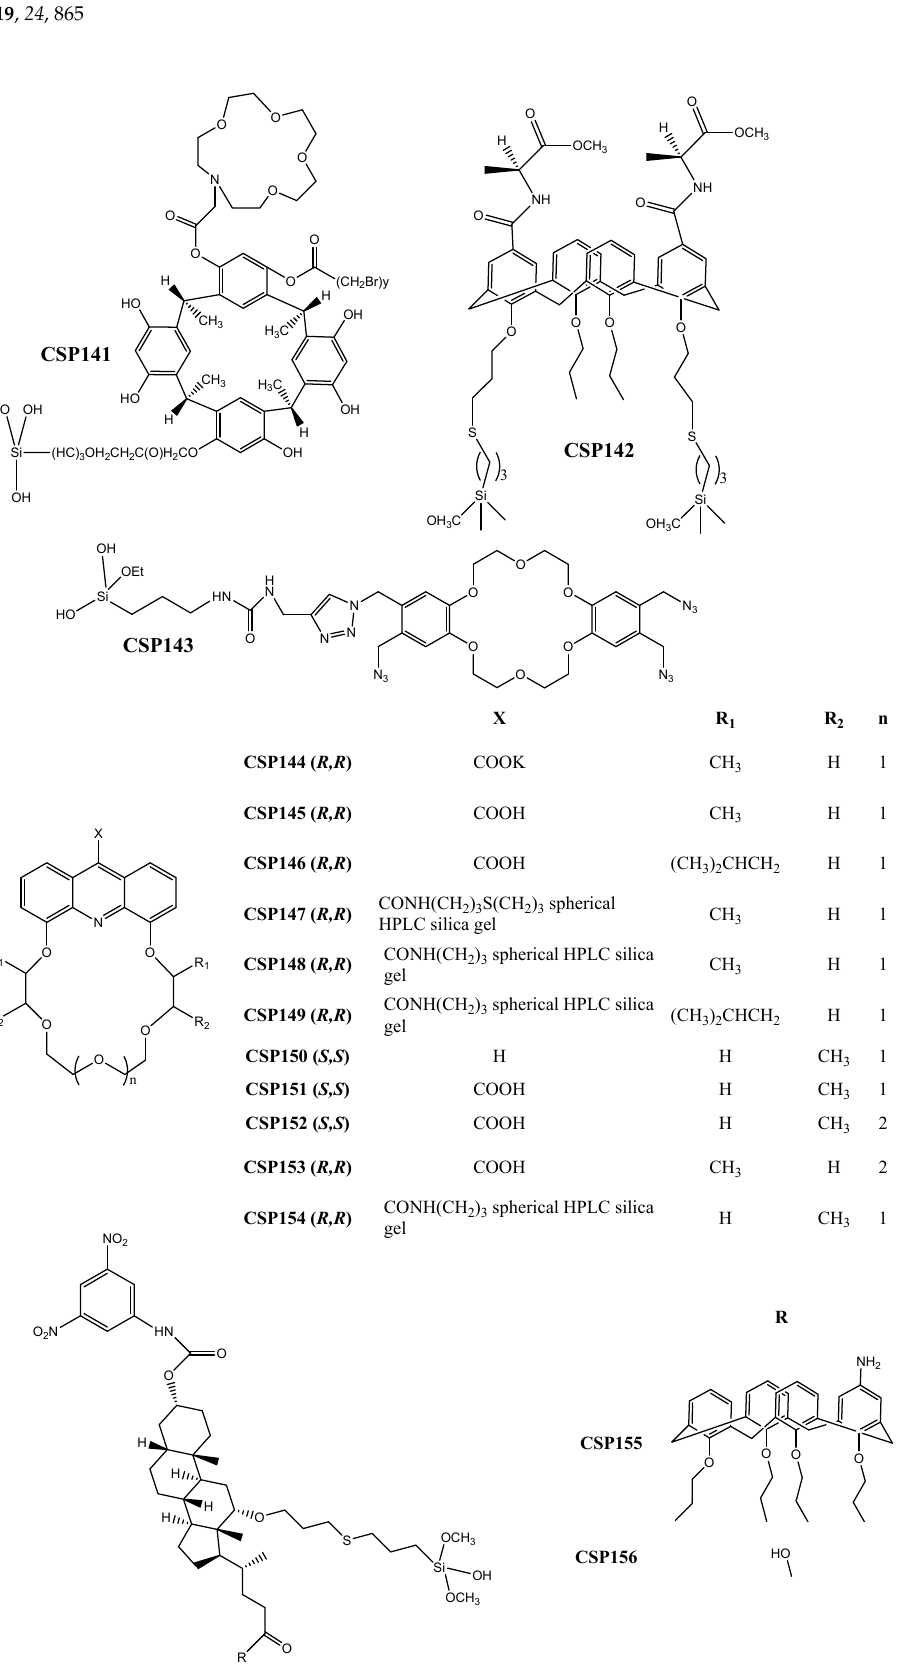
Figure 6. Chemical structures of crown-ether-based CSP141–156.